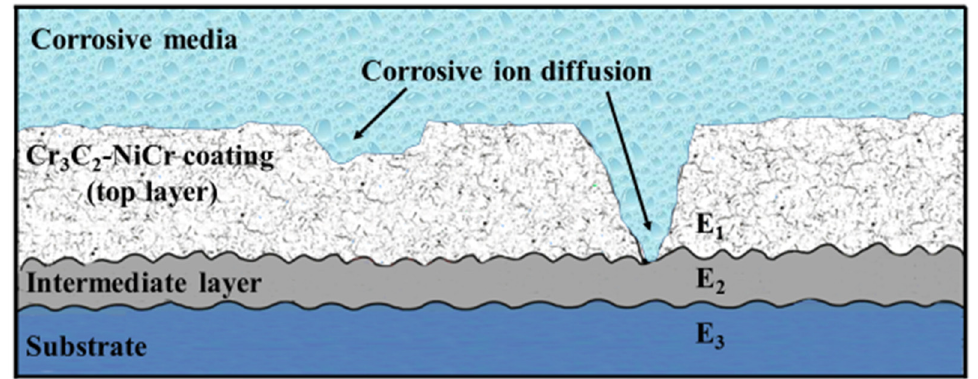
Figure 2. Schematic view of the bilayer coating [4]. (Reproduced from [4] with permission; Copyright 2016 Elsevier). E 1 = corrosion potential of the top layer, E 2 = corrosion potential of the intermediate layer, and E 3 = corrosion potential of the substrate.